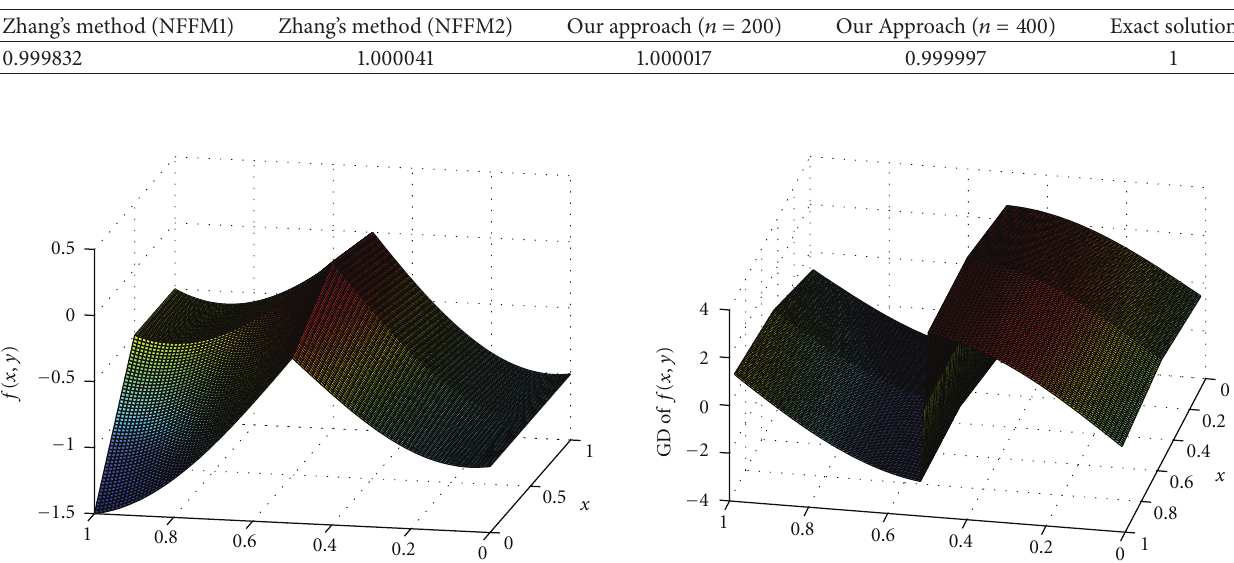
Table 1: Comparison of the Zhang’s method and our approach.